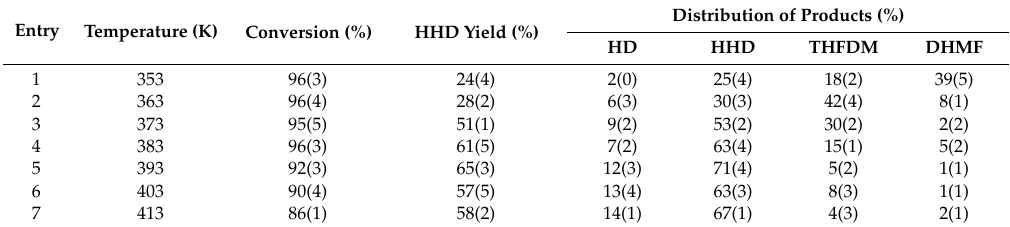
Table 2. Hydrogenation of HMF on Pd / C at di ff erent temperature a .